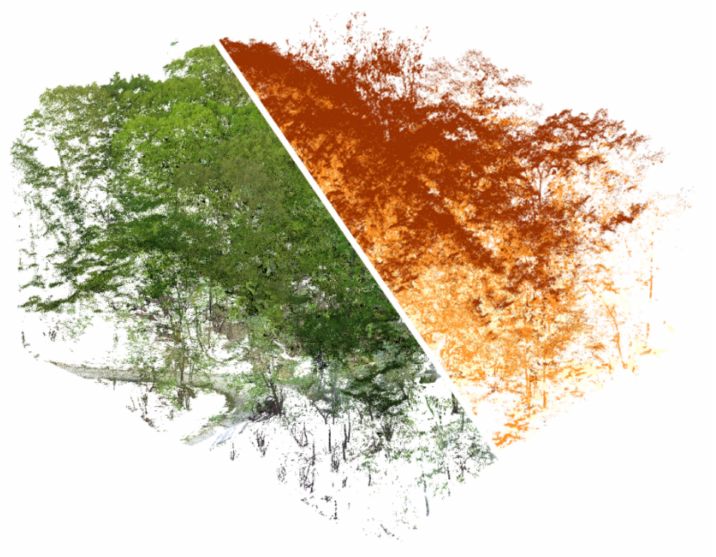
Figure 11. Point cloud acquired by the DJI L1 sensor, visualized in RGB ( left ) and in return number classification ( right